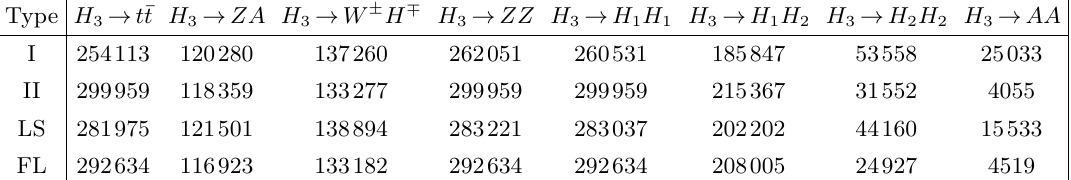
Table 20 . Number of parameter points available for the analysis in the individual OS decay channels of the non-SM-like Higgs boson H 3 ( H 1 is SM-like). { The enhanced relative EW corrections to the BRs of the decay channels H